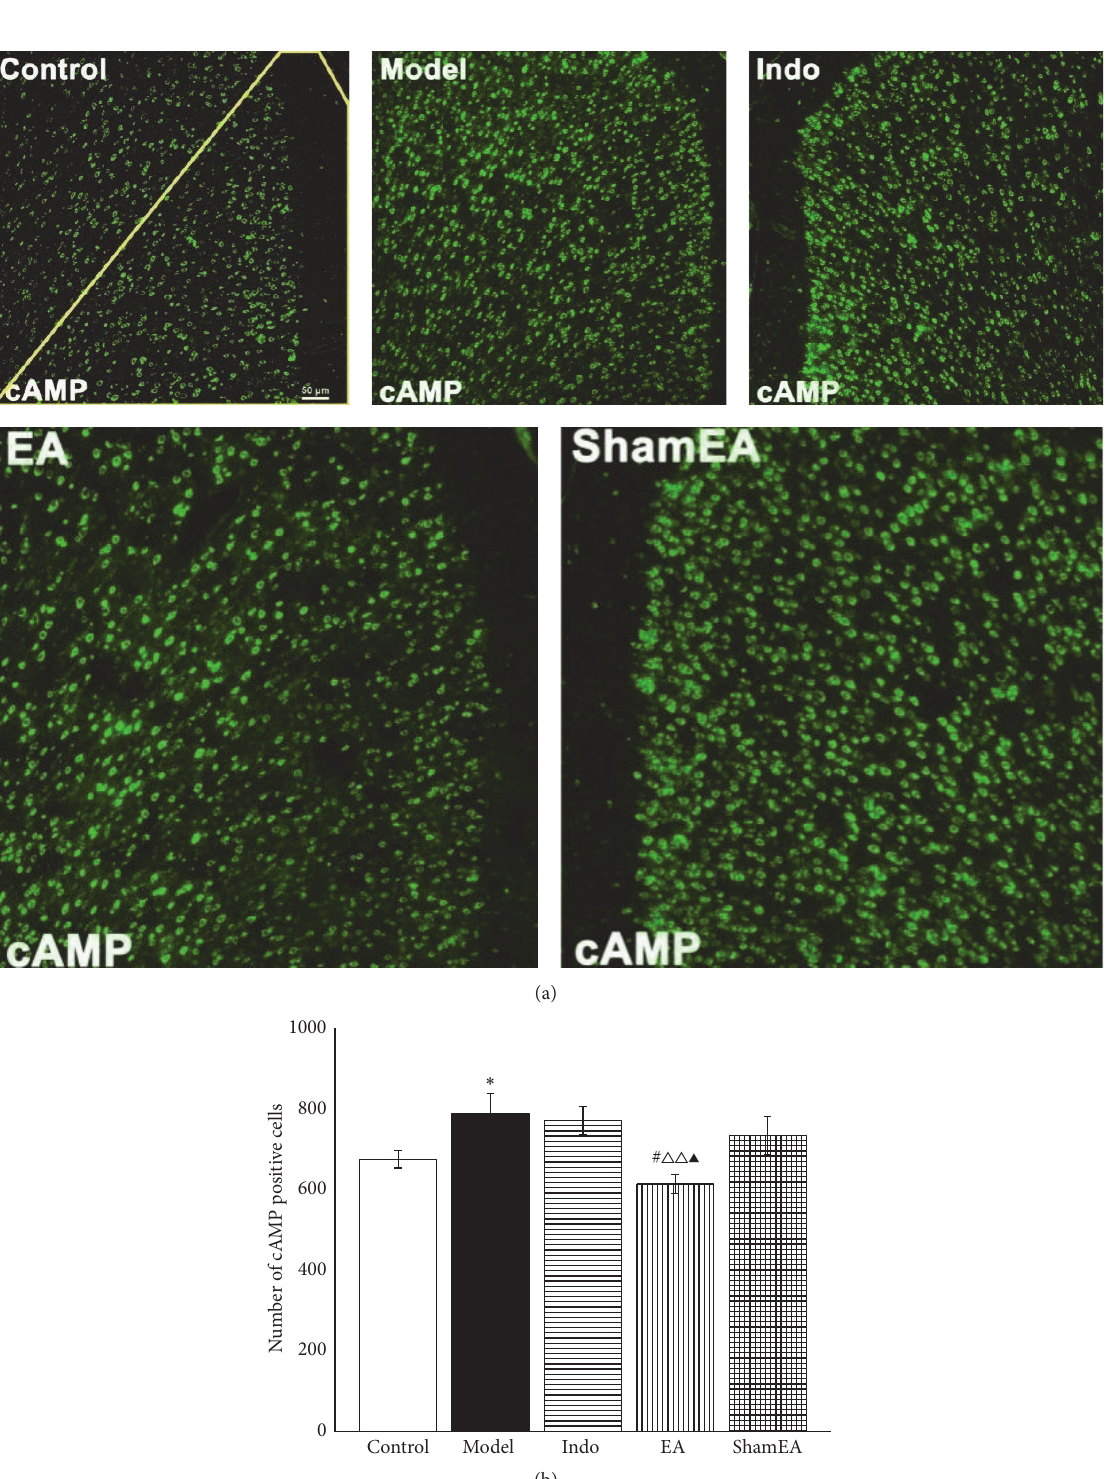
Figure 5: EA inhibited the activation of cAMP in the ACC of pain memory model rats. The right ACC tissues from the control, model, indo, EA, and sham EA groups were prepared and labeled with immunofluorescence ( 𝑛 = 3 , five slides for each rat). (a) Views of cAMP-positive cells (scale bar, 50 𝜇 m). The yellow line indicates the field in which the positive cells were counted. (b) Quantification of cAMP-positive cells showed that EA treatment at the first injection time point significantly reduced the activation of cAMP. Error bars indicated SEM. ∗ 𝑝 < 0.05 , versus the control group; # 𝑝 < 0.05 , versus the model group; △△ 𝑝 < 0.01 , versus the indo group; 󳵳 𝑝 < 0.05 , versus the sham EA